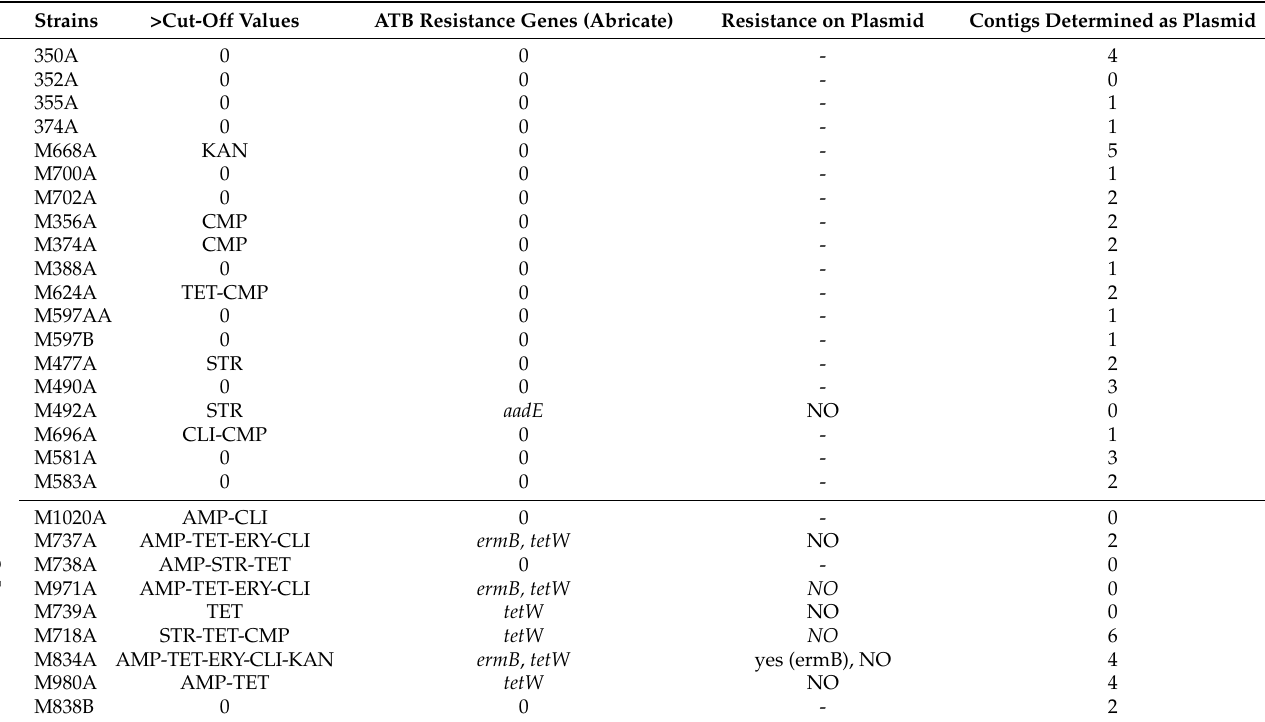
Table 4. Antibiotic resistance in individual L. amylovorus strains and association with plasmid determination. ATB Resistance Genes